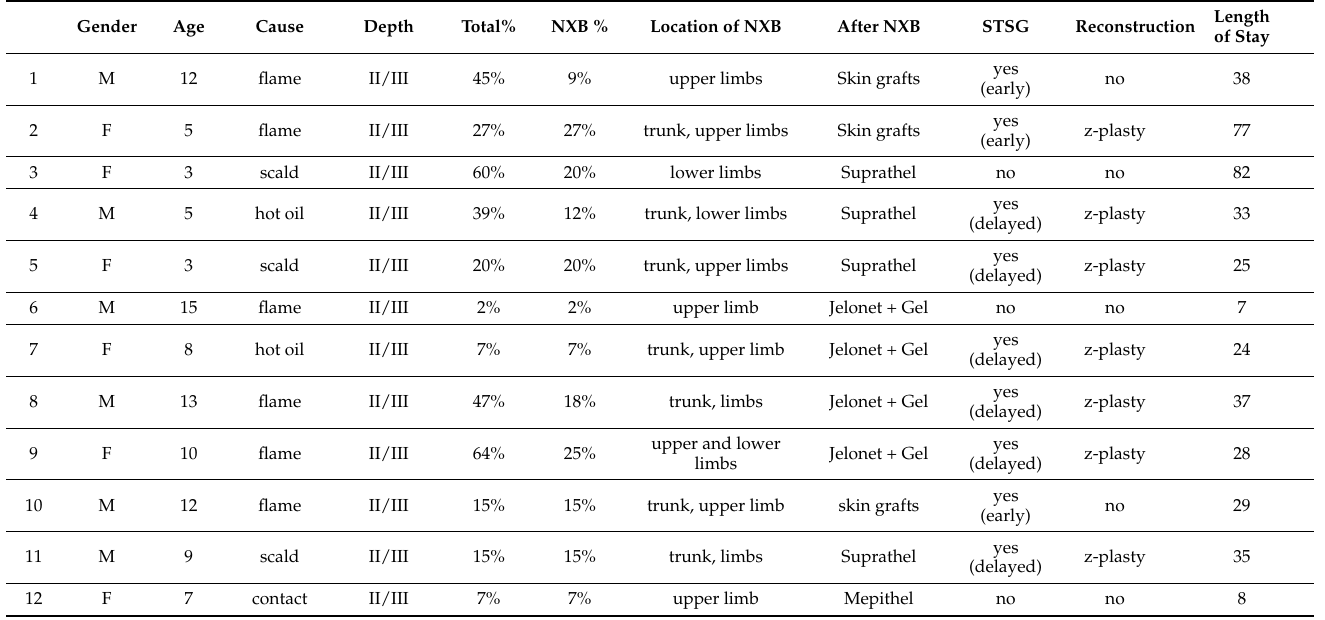
Table 1. Characteristic of the study group treated enzymatically using Nexobrid ®